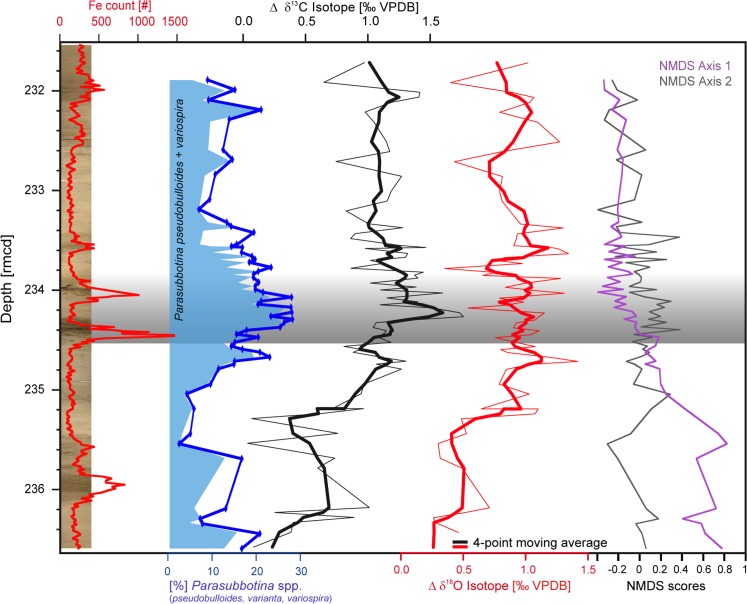
δ13C and δ18O gradient and faunal development.Gradient of δ13C and δ18O signals calculated by planktic surface minus subsurface dwelling foraminifera, expressed as Δδ18O and Δδ13C. A four-point moving average has been applied. The core photo and the XRF core scanning Fe counts serve for stratigraphic correlation. In addition results from non-metric multidimensional scaling (NMDS) as a statistical measure of the faunal composition are shown (see also Fig 9). The LDE is marked in grey. Data available in S1 and S2 Tables.